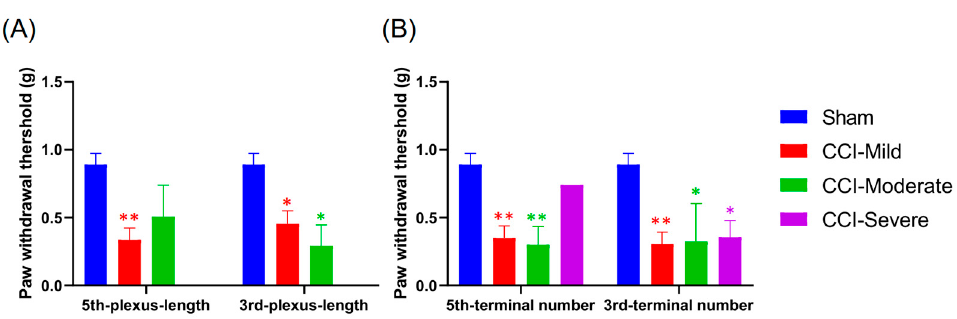
Figure 9. The ability of the indices of plexus length and number of terminals at 7 d to estimate mechanical threshold at 14 d. ( A ) The CCI-mild group showed mechanical hypersensitivity whether indexed by plexus length in the third or the fifth toe tip. The CCI-moderate group revealed mechanical hypersensitivity when indexed by plexus length in the third toe. ( B ) The CCI-mild and CCI-moderate groups displayed mechanical hypersensitivity whether indexed by number of nerve terminals in the third or the fifth toe tip. The CCI-severe group showed mechanical hypersensitivity when indexed by number of terminals in the third toe. * p < 0.05, ** p < 0.01, compared to the sham group.